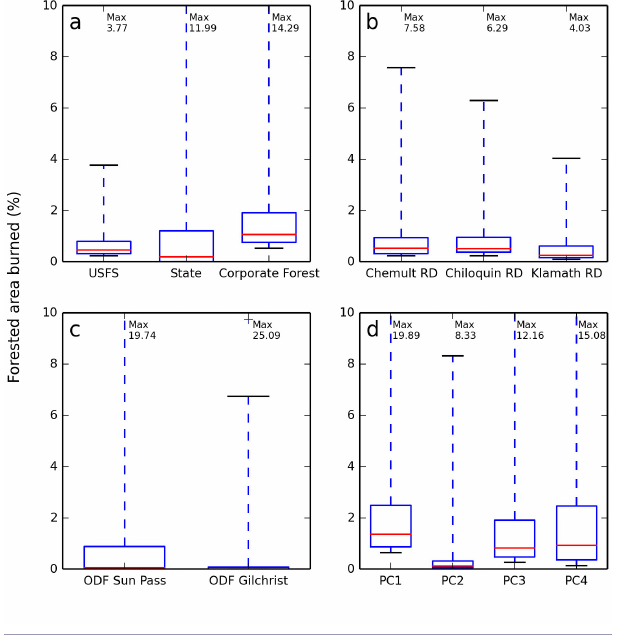
Fig. 7 . Box and whisker plots of for annual percentage of ownership experiencing stand-replacing wildfire (loss) in all fire years under current management, between and within ownership categories, for the top 10% of worst fire years ( n = 75 out of 750 replication years). Red line = median percentage of ownership burned; blue box = 25th to 75th quartiles. Table 9. Fire incidence indices for different ownership types and